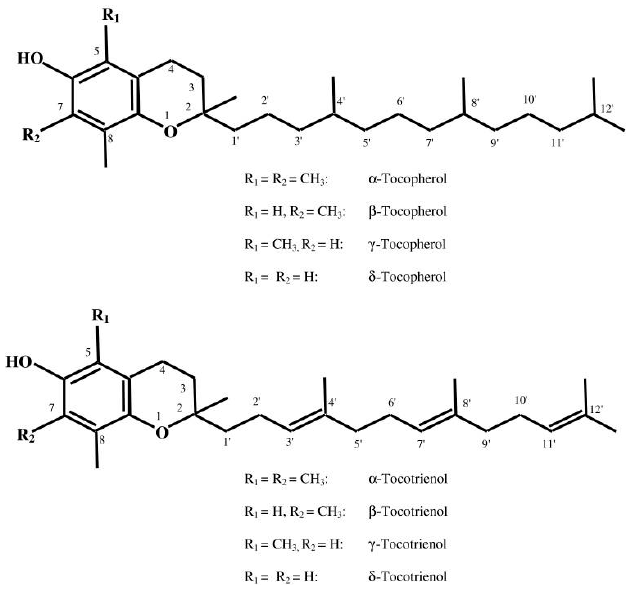
Figure 1. Structure of tocopherols and tocotrienols (with permission from reference